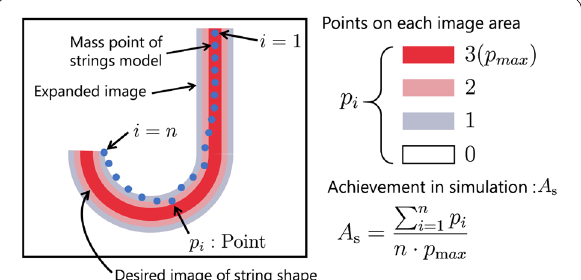
Fig. 4 Evaluation of achievement in